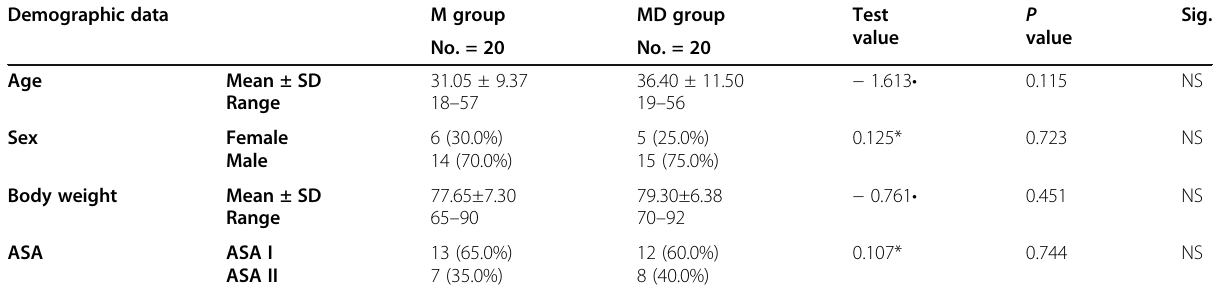
Table 1 Demographic data Demographic data